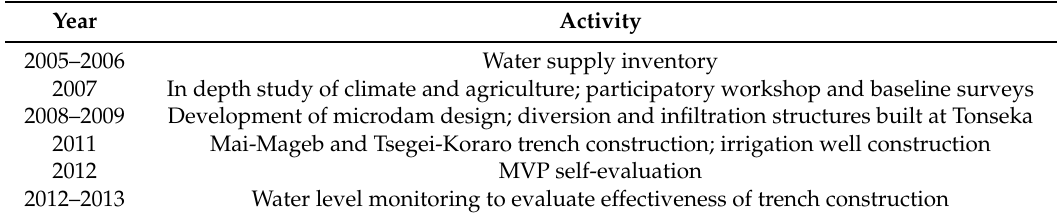
Table 2. Timeline of work in